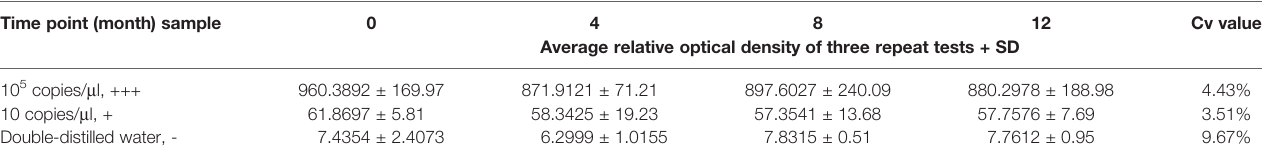
TABLE 2 | Readability and stability assay of RT-RAA-LFA.